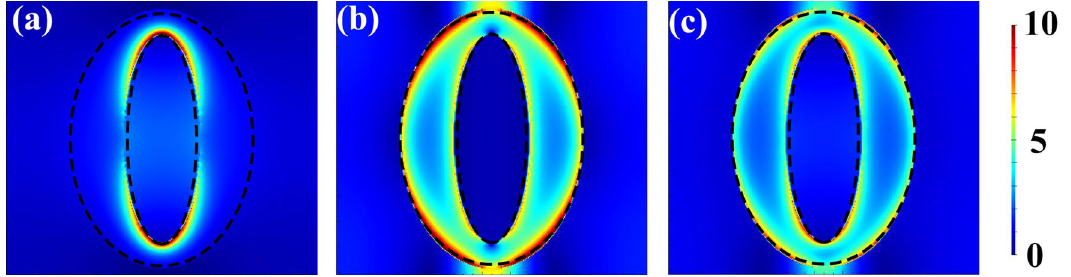
Figure 5. Electric field distribution of the proposed NCQW. ( a ) x -polarized, ( b ) y -polarized and ( c ) xy - polarized incident light at the wavelength of 834 nm. The parameters are r 1 = 40 nm, r 2 = 125 nm, R 1 = 97 nm, R 2 = 156 nm, h = 8 nm, and p = 330 nm, respectively. Lumerical FDTD Solutions; version: 8.23.2305. www. lumer ical. com.